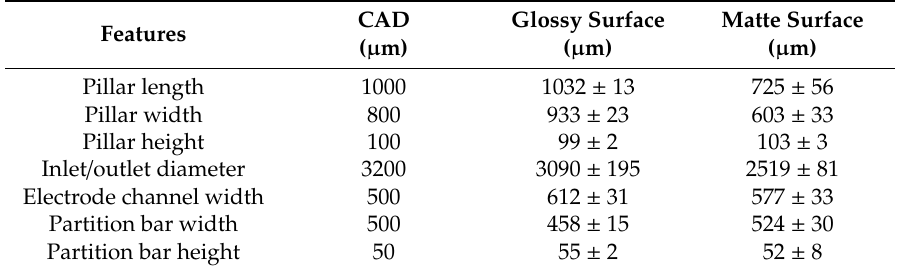
Table 1. CAD values versus real values.